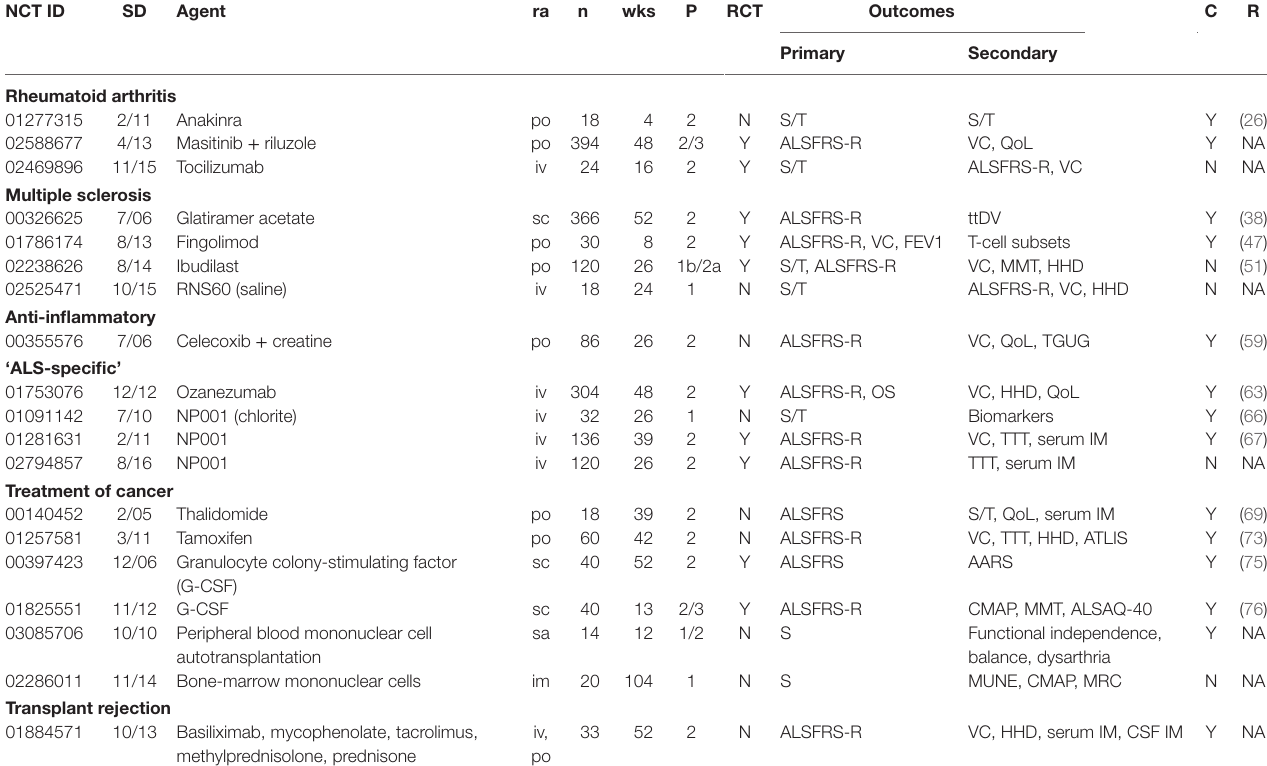
TAbLe 1 | Trials of immune-modulating treatments in ALS registered with